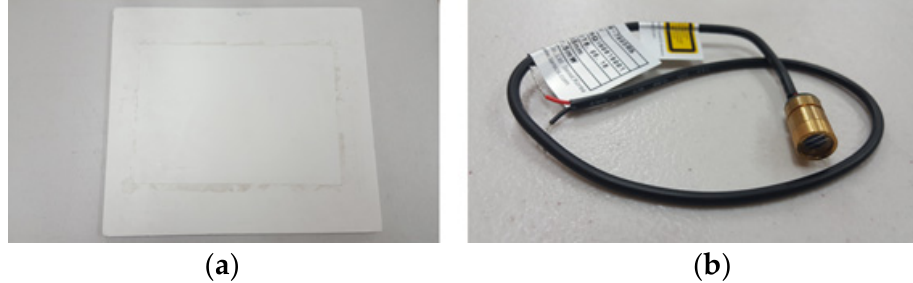
Figure 2. Calibration tool to calibrate the sensor. ( a ) calibration object; ( b ) line laser.